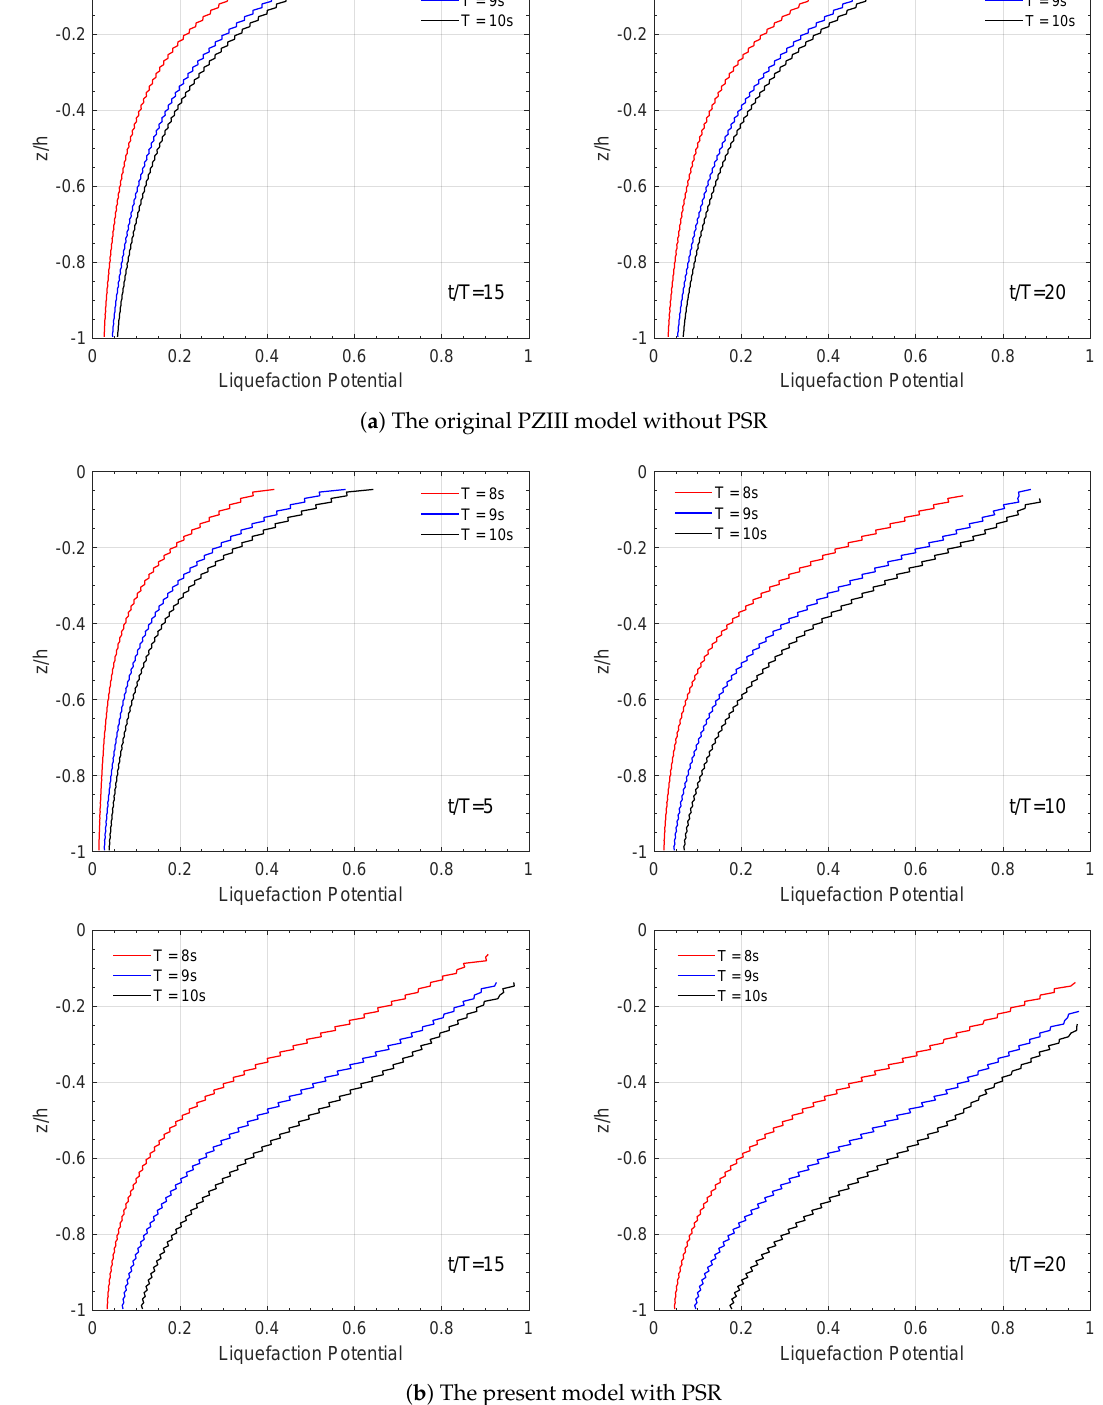
Figure 12. Effect of wave period T considering PSR on the vertical distribution of liquefaction potential on z = − 5 m at four typical time points. ( a ) The original PZIII model without PSR and ( b ) the present model with